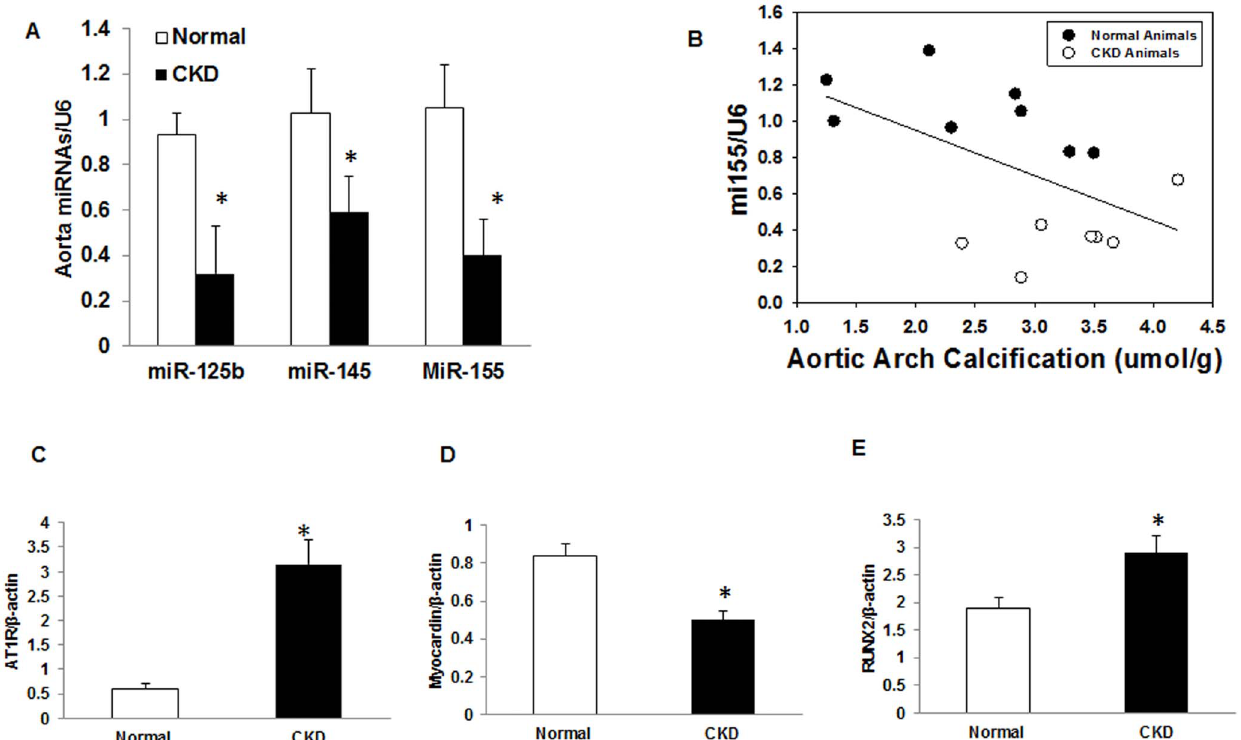
Figure 2. Decreased expression of miRNAs and downstream genes in thoracic aorta from CKD animals. Thoracic aorta were collected at 35 weeks of age from CKD (n=8) and normal rats (n=8) and total RNA was isolated and miRNA expression determined by real time PCR and normalized by U6. The results demonstrated that there is significantly reduction in expression in miR-125b, miR-145, and in thoracic aorta from CKD compared to that from normal rats (Figure 2A). Aortic calcification was determined biochemically and results demonstrated that aorta calcification is increased in CKD rats and the greater the calcification, the lower the miR-155 expression level (r=0.54, p=0.04; Figure 2B). Real time PCR was also performed to determine the expression of several target genes and normalized by b -actin. The results demonstrated that the expression of AT1R (Figure 2C) and RUNX2 (Figure 2E) is increased whereas myocardin expression is decreased (Figure 2D) in aorta from CKD rats compared to normal rats, corresponding to known physiologic roles of these vascular miRNA. Data were expressed as mean 6 SEM. * p , 0.05, CKD vs.